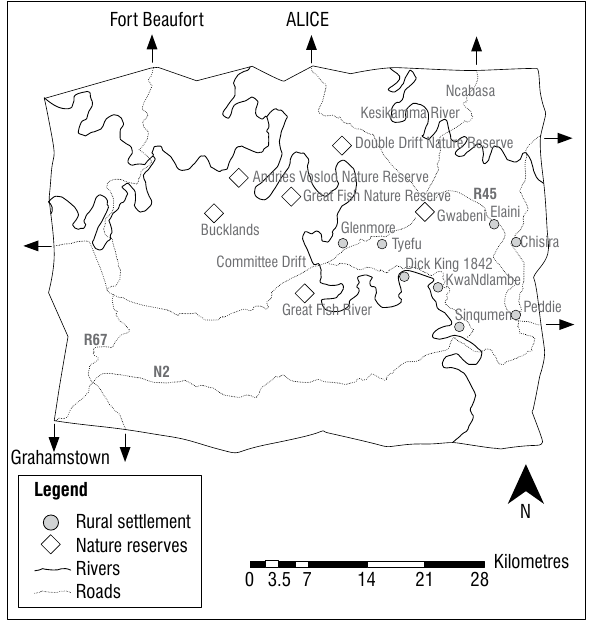
Figure 1: Map of the Great Fish River Nature Reserve and its environs – the study area.